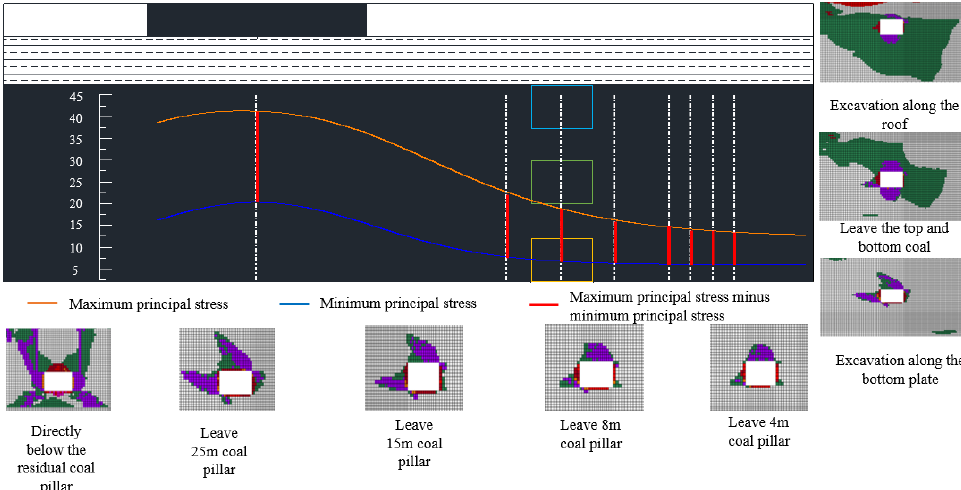
Figure 32. Principal stress distribution and the plastic zone area under different roadway layout positions.